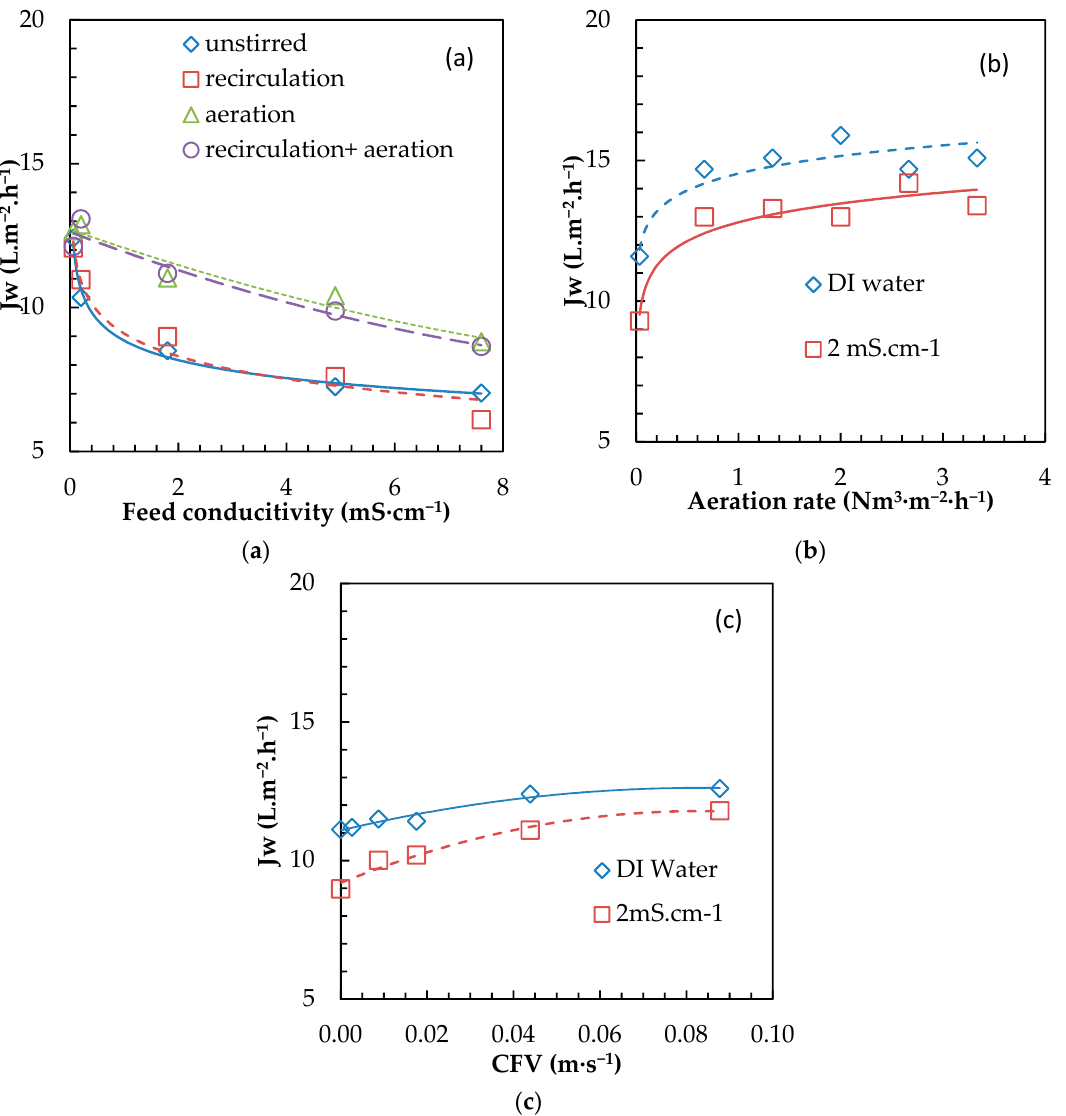
Figure 8. Impact of ( a ) aeration and recirculation, ( b ) intensity or aeration and ( c ) CFV of recirculation on water permeation flux (35 g·L − 1 SW as the draw solution, U-shape large-mesh plate).